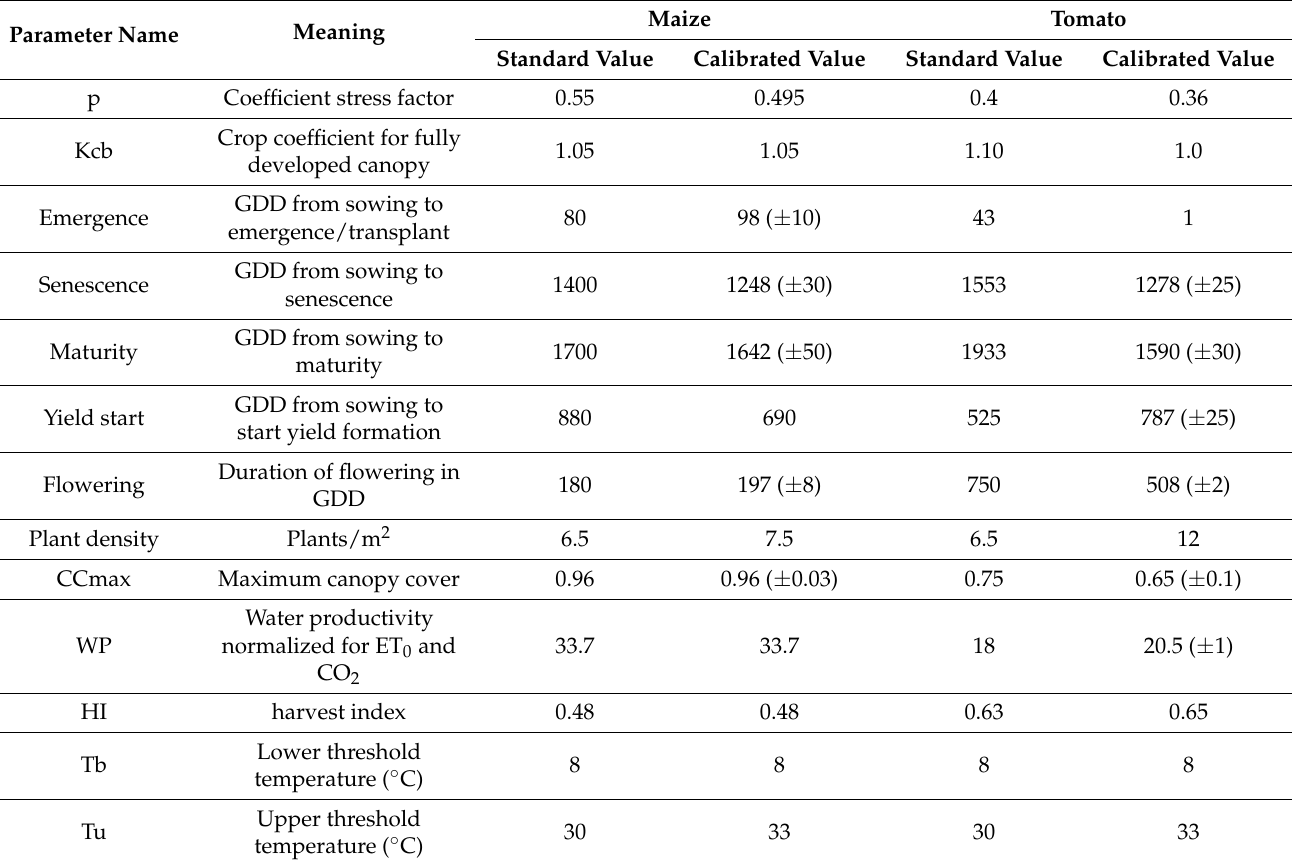
Table 3. Main calibration crop parameters for all the fields from the literature values and after the calibration